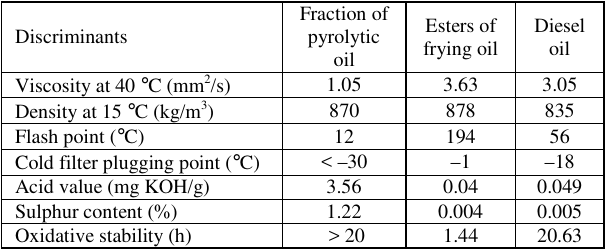
Fig. 1. TLC chromatogram of esters obtained by the double base-acid transesterification After preparing the components of the mixture, each of them has been analysed in terms of a kinematic viscosity at 40°C (ISO 3104), density at 15°C (ISO 12185), temperature of flash point (PN-EN ISO 3679), temperature of cold filter plugging point (EN 116), sulphur content (EN ISO 20884) and oxidation stability (ISO 14112) (Table 2). Table 2. Characteristics of the prepared raw